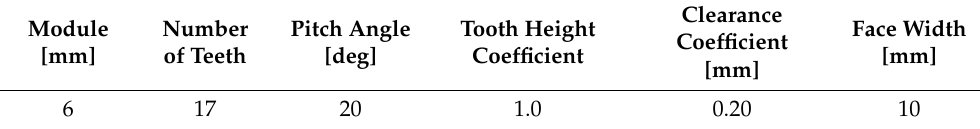
Table 1. The machined gear parameters.